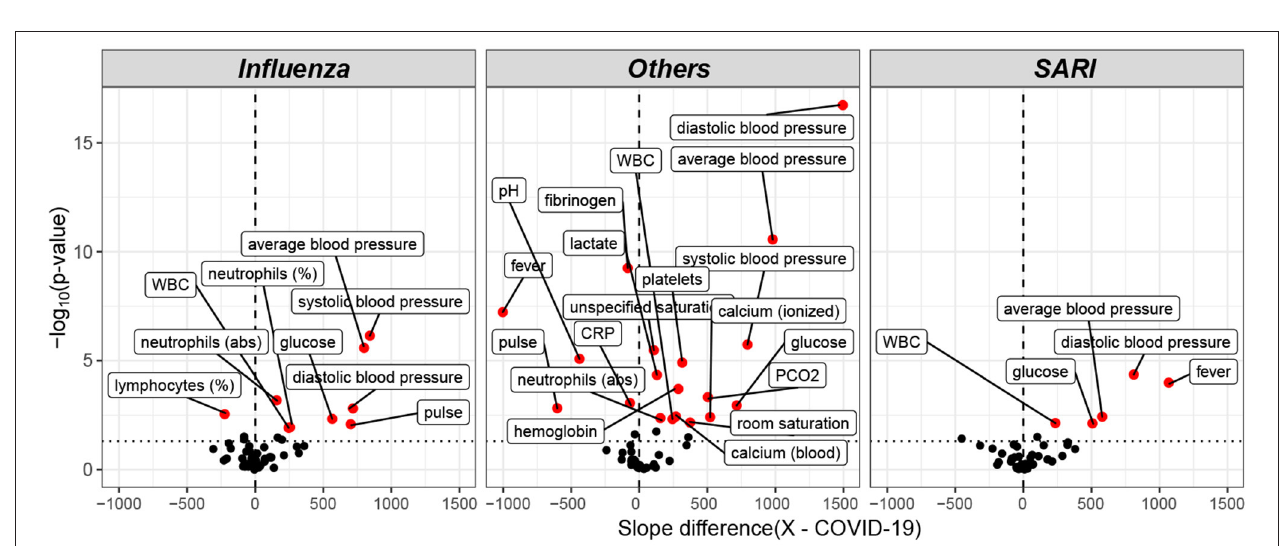
FIGURE 4 | Comparing trends across time—ranks means vs. time intervals. Blood pressure and pulse were decreasing more slowly during 6–48 h after admission among COVID-19 patients compared to influenza and SARI patients. Glucose and measures related to white blood cells (white blood count, lymphocytes, and neutrophils) among COVID-19 patients showed distinct trajectories, with respect to other patients.